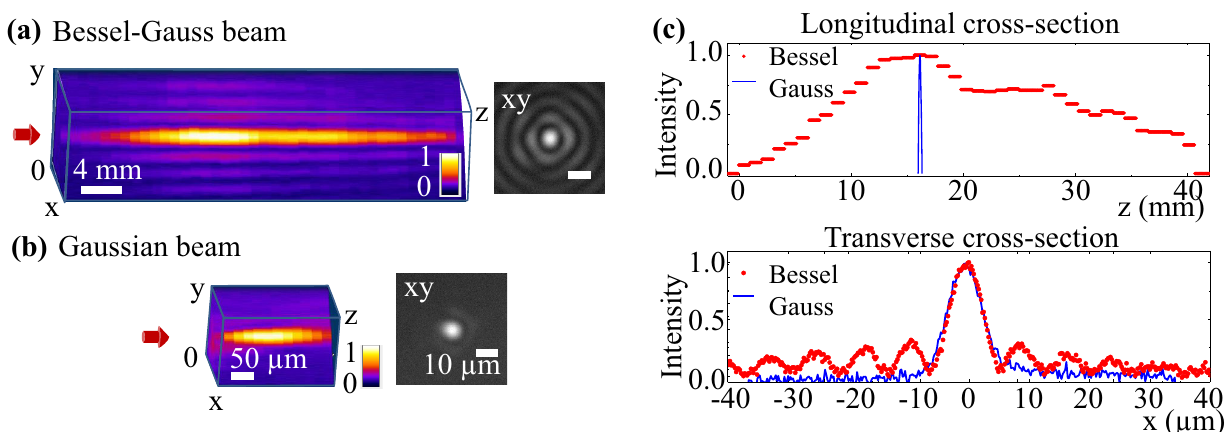
3 Figure 1. ( a ) Experimental analysis of the non-diffractive Bessel beam with the conical half-angle θ ◦ , the = central core diameter 2 r b = 11 μm, and the Bessel length z b = 43 mm. The transverse beam profile consists of a high-intensity central core surrounded by a series of low-intensity concentric lobes. ( b ) Experimental analysis 11 μm at 1/ e 2 , and the depth of focus (confocal range) z g = of Gaussian beam with the beam diameter 2 r g = 0.24 mm. The 3D illustration of the beams was stacked from transverse beam profiles individually captured along the propagation axis. ( c ) The on-axis cross-sectional profiles in the central core region of the beams (upper graph) and transverse cross-sections (lower